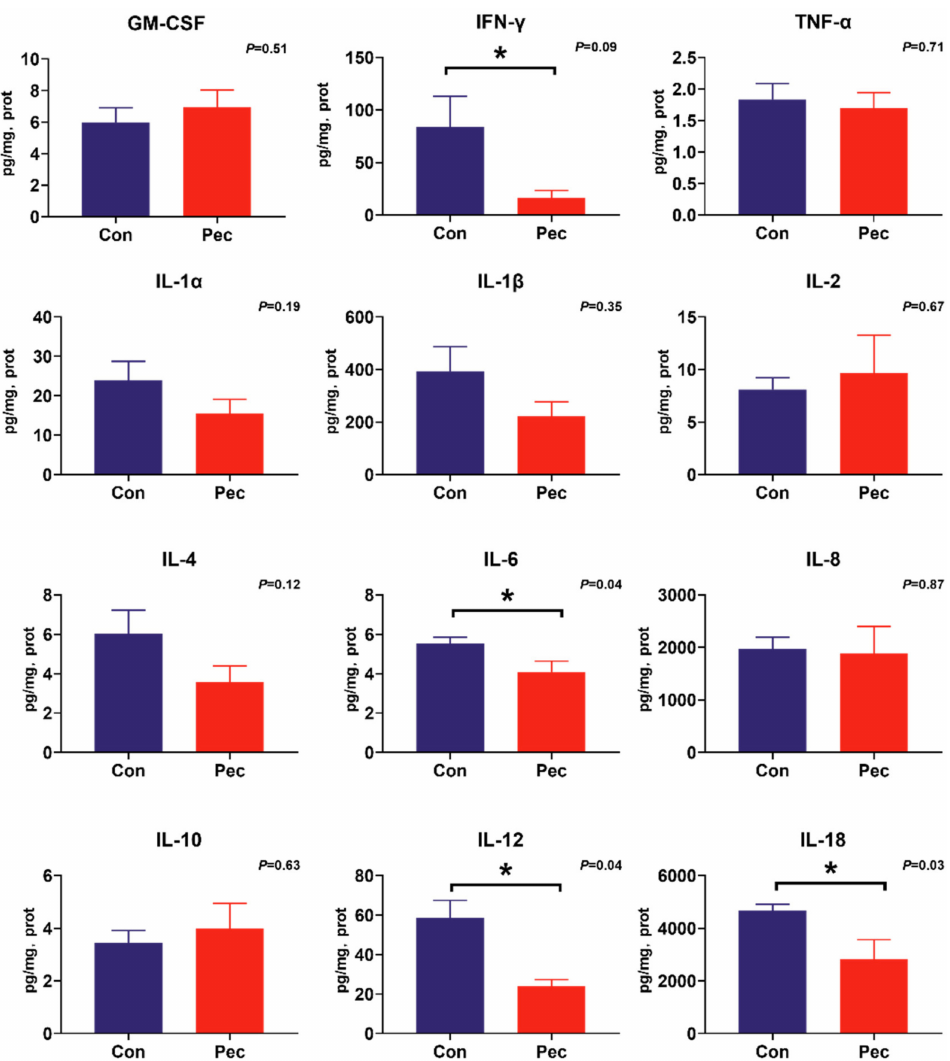
Figure 4. The concentration of cytokine in ileal mucosa of pigs fed either the control or pectin diet. Values are means ( n = 6 / diet), with their standard errors represented by vertical bars. * Means statistically significant ( p ≤ 0 ·